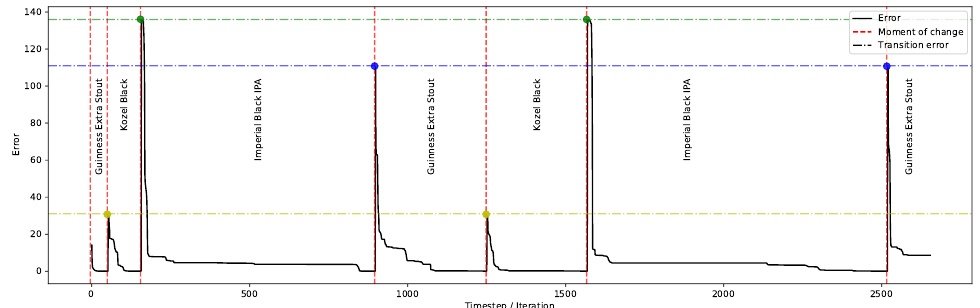
Figure 8. Applying drastic changes to preferences: switching from one product to the next. The dashed vertical lines represent the moment of change from one set of organoleptic properties to the next, and the horizontal lines present the transition error for each of the